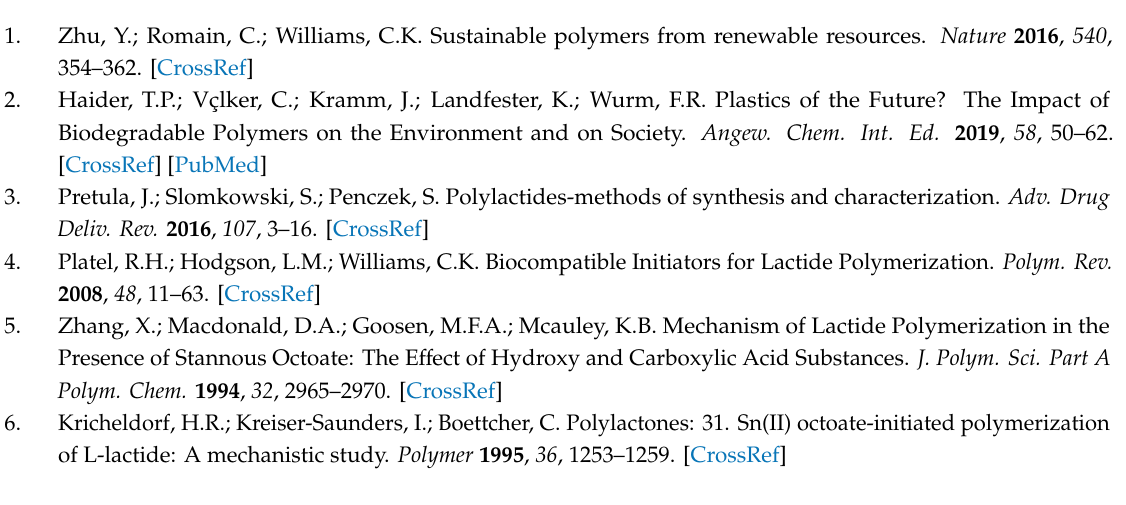
Figure S1: FTIR spectra of (a) Zn(Ala) 2 , (b) Zn(Phe) 2 , and (c)Zn(Pro) 2 , Figure S2: Relative crystallinity as a function of time at 125 o C for PLLA obtained by (a) Zn(Ala) 2 , (b) Zn(Phe) 2 , (Sn(Oct) 2 as reference), Figure S3: Avrami plots of isothermally crystallized 125 o C for PLLA obtained by (a) Zn(Ala) 2 , (b) Zn(Phe) 2 , (Sn(Oct) 2 as reference), Figure S4: DTG curves of PLLA obtained by (a) Zn(Ala) 2 , (b) Zn(Phe) 2 , and (c) Zn(Pro) 2